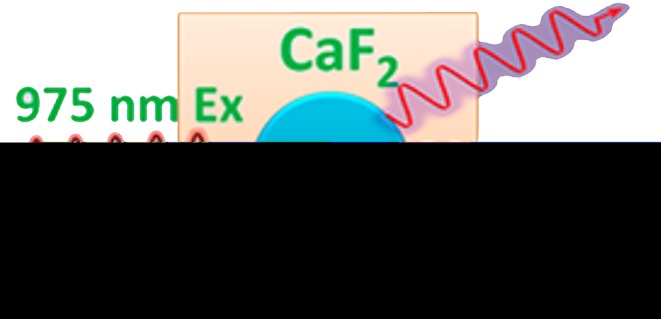
Structure of (α-NaYbF4:Tm3+)/CaF2 upconverting nanoparticles (Chen et al., 2012). Reproduced with permission. Copyright 2012 American Chemical Society.